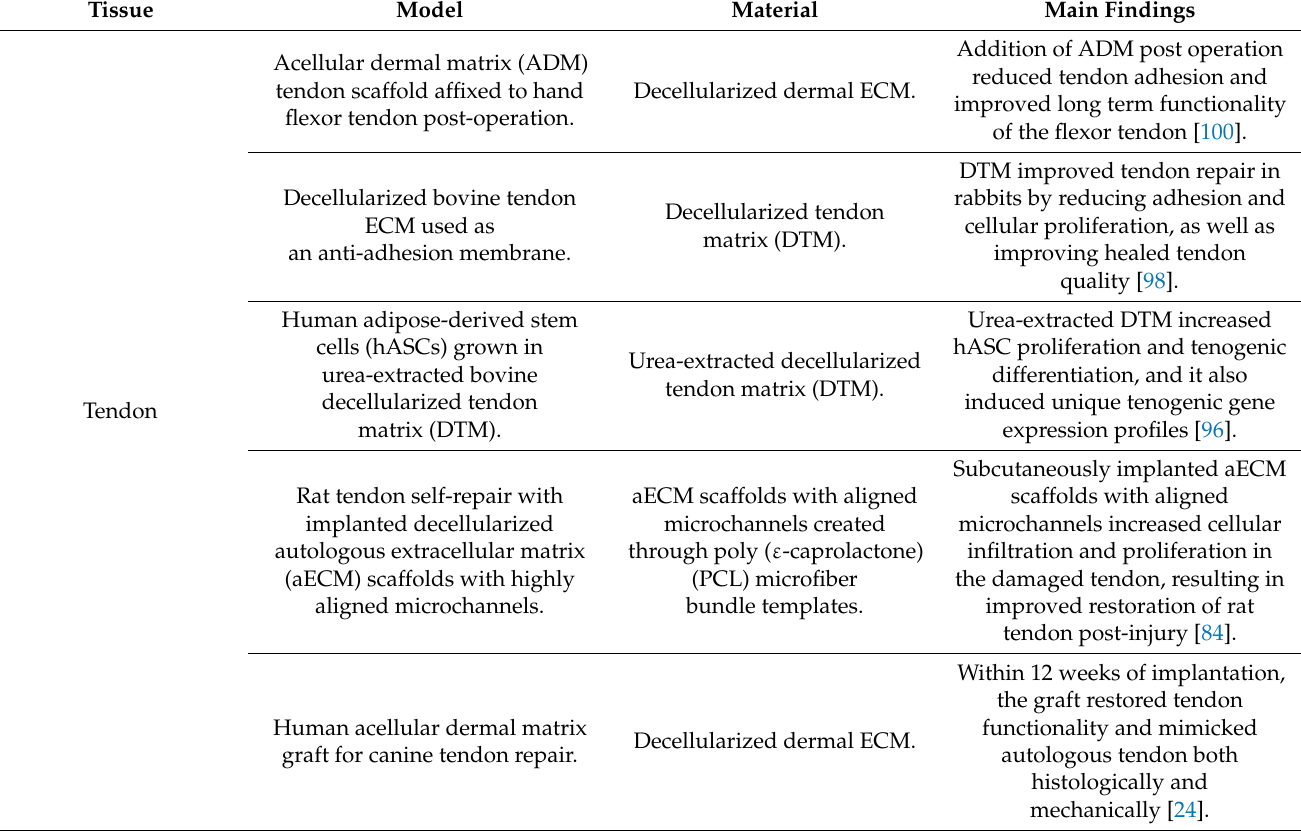
Table 3. Recent and noteworthy studies focused on cell–ECM–material interactions in